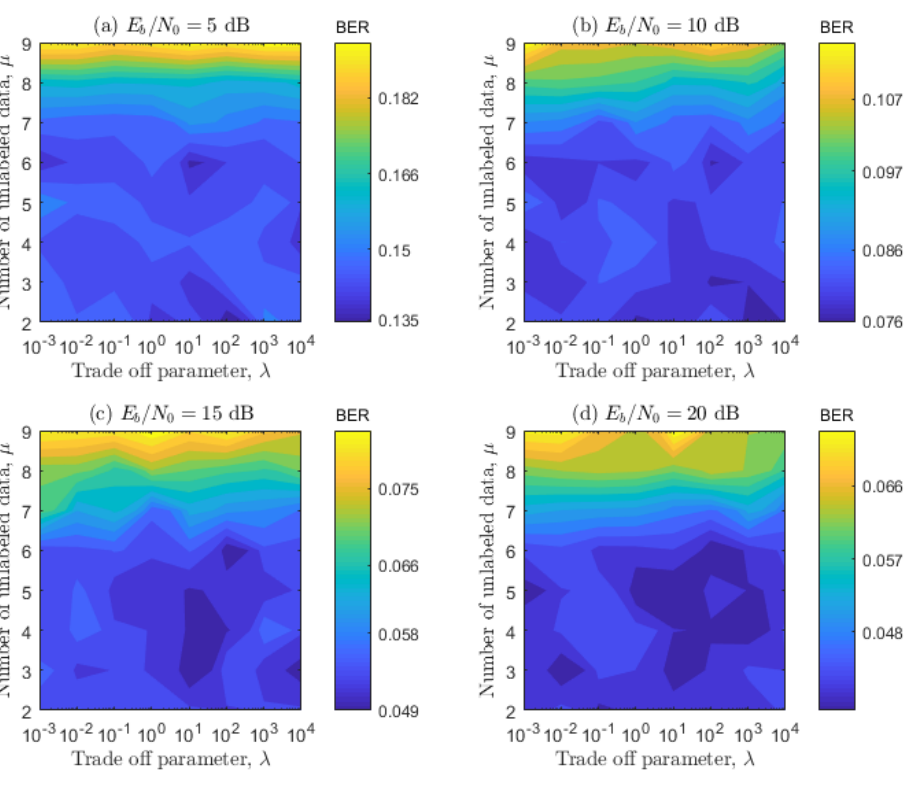
Figure 10. BER contour plot of λ and µ for different E b / N 0 values and system configuration 1.